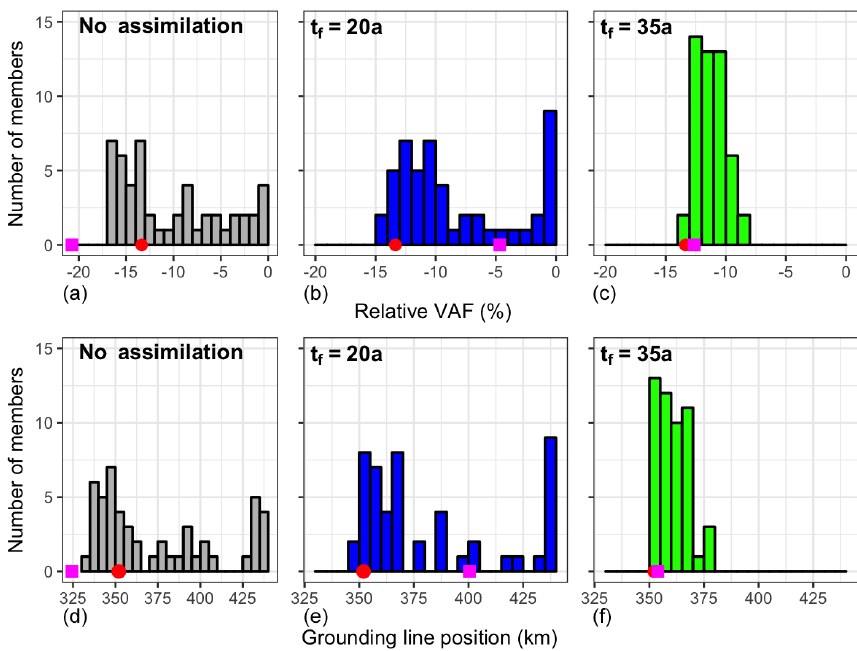
Figure 12. Ensemble forecast at t = 100a: (a) – (c) relative change of volume above floatation (VAF) and (bottom) GL position with (a, b) no assimilation, (b, e) assimilation up to t = 20a and (c, f) assimilation up to t = 35a. The red circle correspond to the reference run and the magenta square to the deterministic